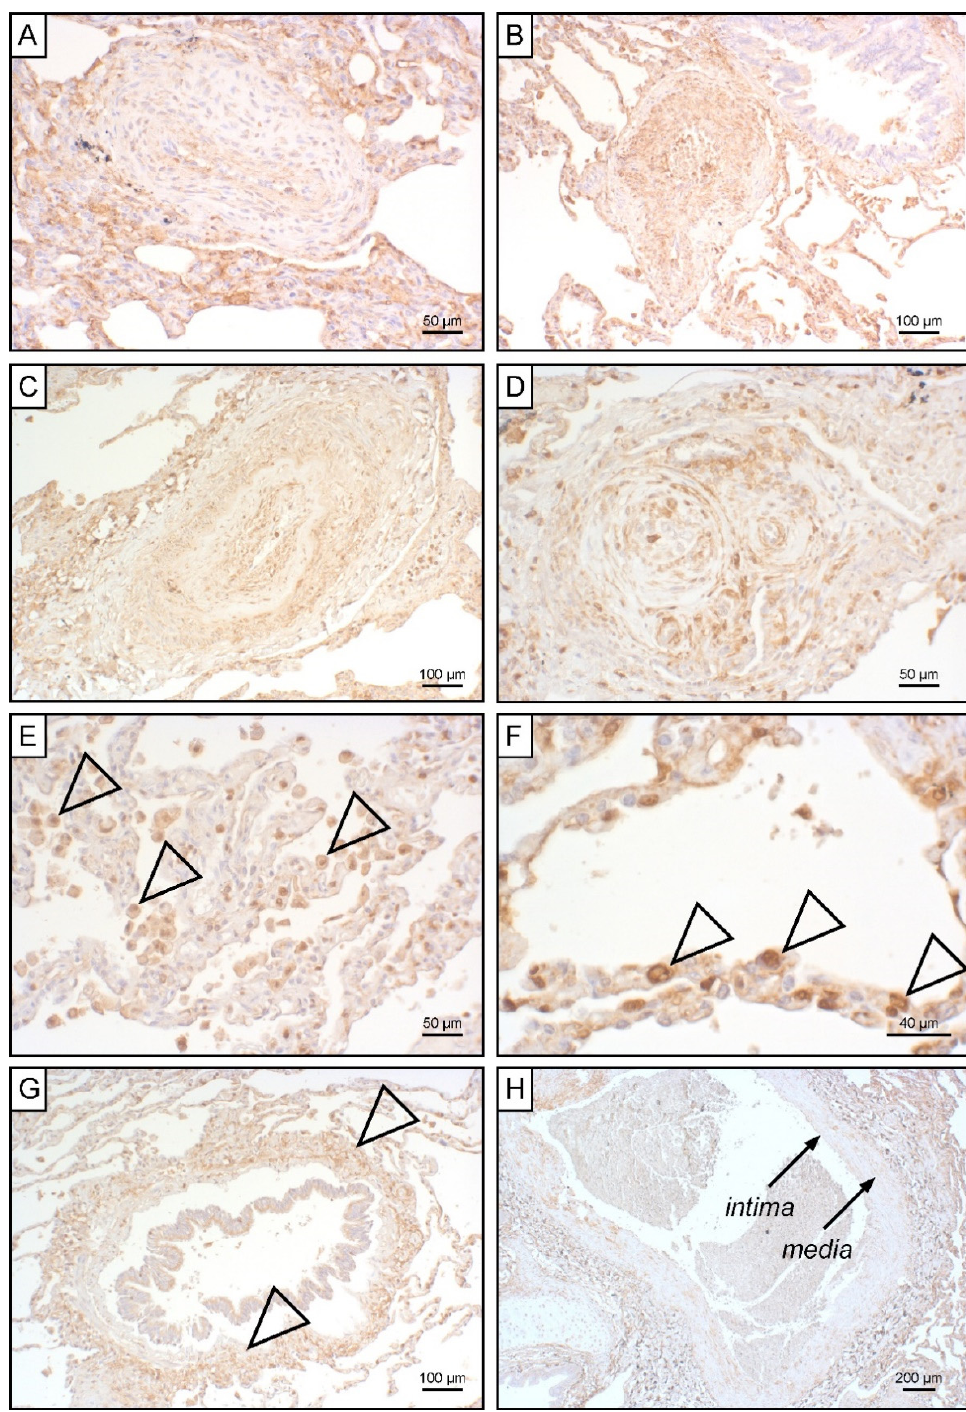
Figure 6. S100A4 expression in iPAH patients. Immunohistochemical staining of S100A4 in iPAH lung tissues. Representative micrographs of characteristic pulmonary artery changes in small vessels according to Heath–Edwards classification ( A ) grade I, ( B ) grade II, ( C ) grade III, and ( D ) grade IV are shown. ( E ) Alveolar macrophages, ( F ) alveolar epithelium, ( G ) peribronchiolar fibrous tissue, and ( H ) tunica intima and tunica media of larger pulmonary vessels positive for S100A4 are shown. Tissues of interest are highlighted by open arrowheads.